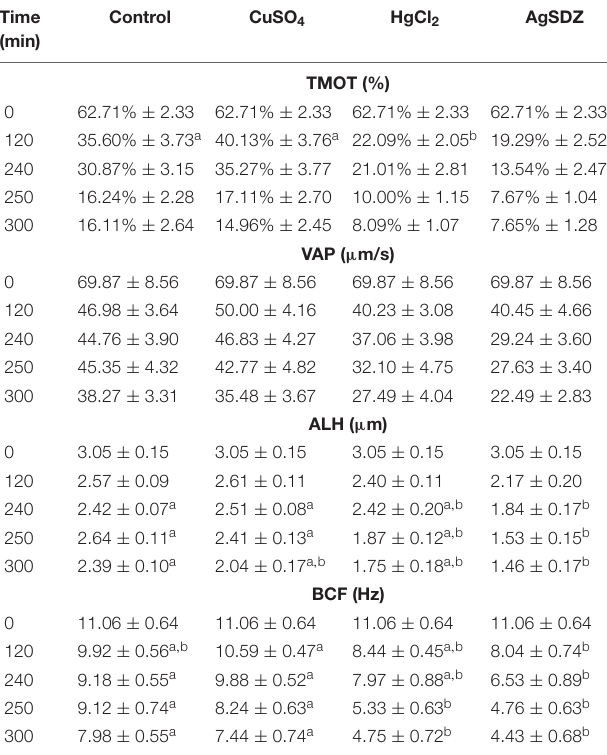
Linearity (LIN, %), straightness (STR, %) and oscillation index (WOB, %) from samples exposed to the presence or absence of different AQP inhibitors in the capacitation medium: cooper sulfate (CuSO 4 ), mercury chloride (HgCl 2 ) and silver sulfadiazine (AgSDZ). Datawerecollectedafter0,120,and240minofincubationincapacitationmedium. At this point, progesterone was added to capacitation medium (arrow) and data were collected after additional 10 and 60 min of incubation. Data are shown as mean ± SEM, and different letters (a,b) indicate significant differences (P < 0.05) between different treatments within a given time